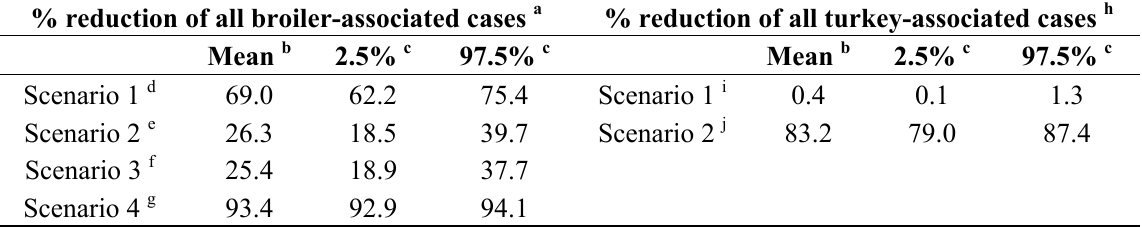
Table 5. Estimated reduction in percentage (%) of human salmonellosis cases in the EU originating from the broiler reservoir [7,15] and the turkey reservoir [8,18] when compared to the baseline model under the different